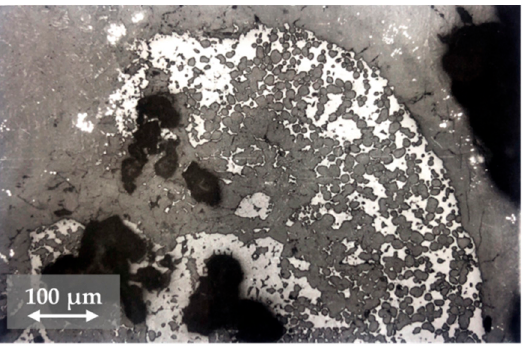
Figure 4. Decomposition of the lime part in the slag after minute 8 of oxygen blowing. Sample D8, Melting Process D.